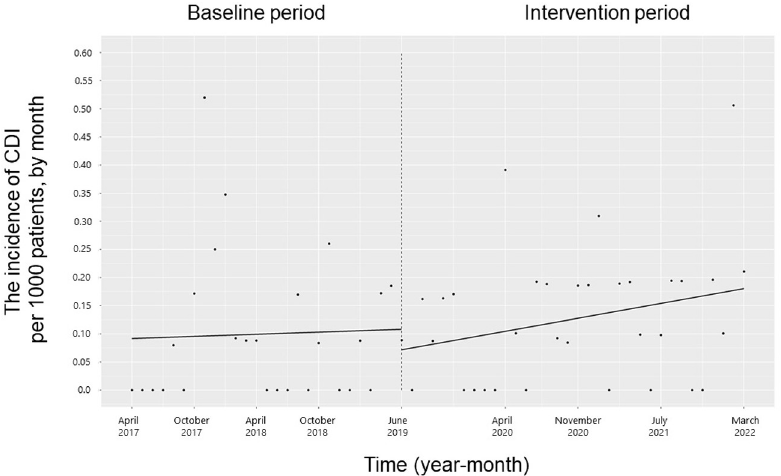
Fig 10. Trends in the incidence of Clostridioides difficile infection (CDI) per 1000 patients, by month, during the pre-intervention period (Phase 1) and interventional period (Phases 2–4). Each dot refers to the CDI per 1000 patients each month, and the slope is based on linear regression in the four phases: Phase 1 (pre-intervention period from April 1, 2017, to May 31, 2019); Phase 2 (review of clinical pathways from June 1, 2019, to March 31, 2020); Phase